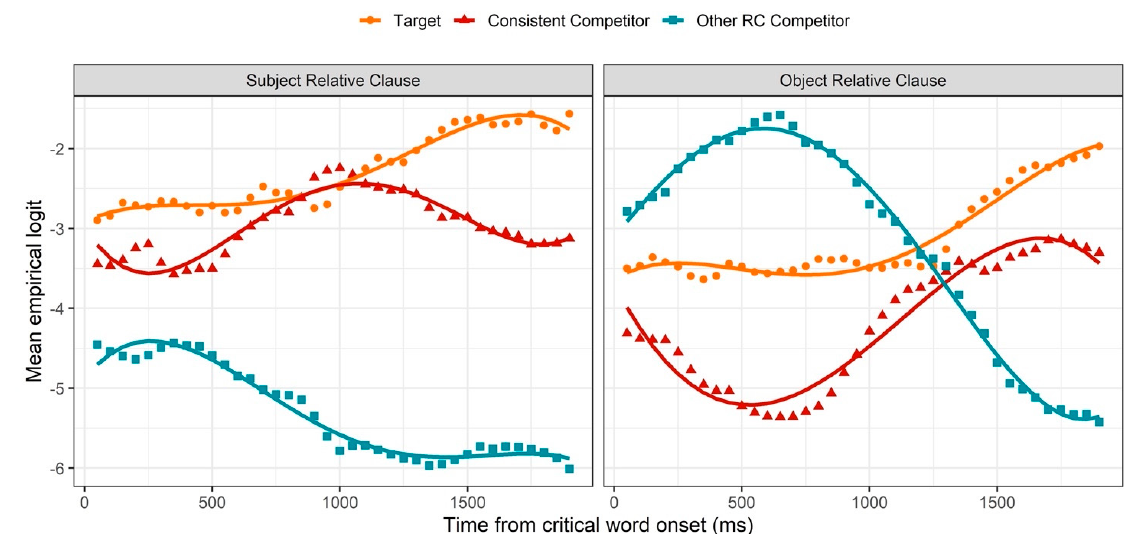
Figure 5. GCA model fit (lines) of empirical logit (points) as a function of image in the visual context and sentence type for the relative clause region.